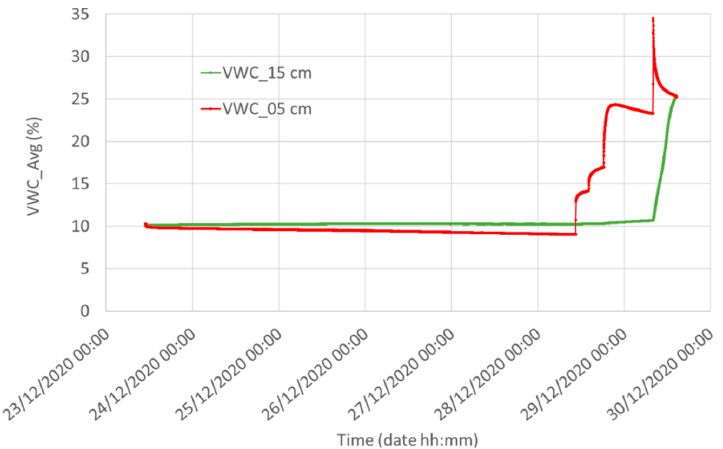
Figure 12. Water content measured by the reference system at two different depths in Silty Loam: red, 5 cm underground, and green, 15 cm underground. red, 5 cm underground, and green, 15 cm